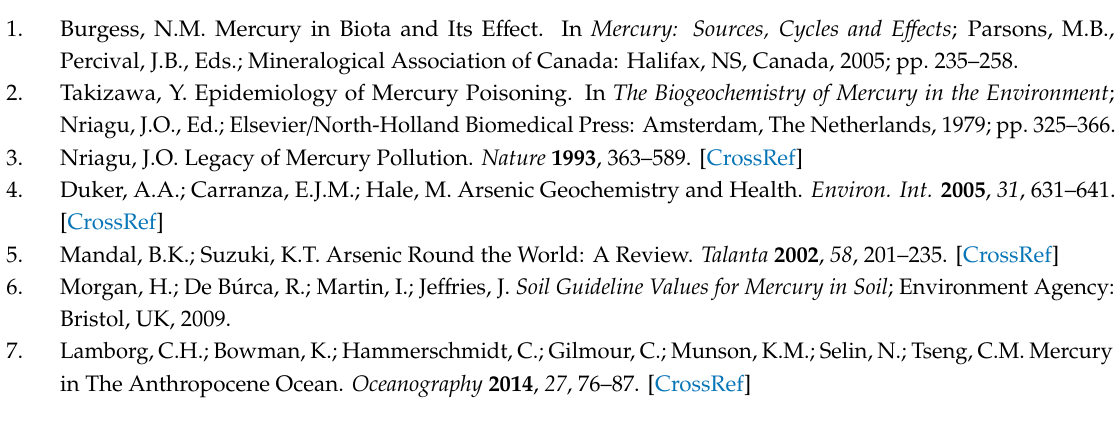
Table S1: Grain size distribution, Table S2: Chemical composition of the studied samples (wt%), Table S3: Concentrations of trace and rare earth elements (mg /